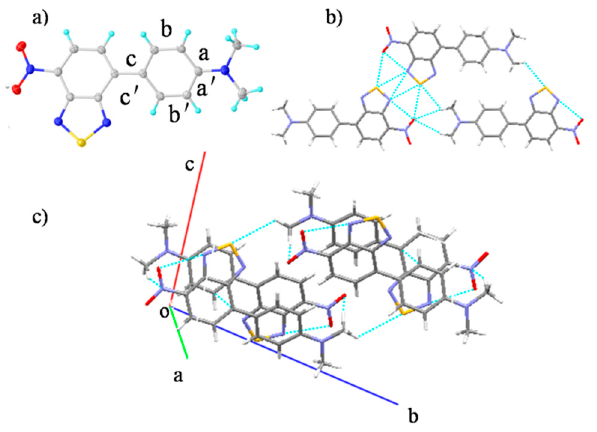
Figure 2. ( a ) Ortep view of BTN with thermal ellipsoids drawn at 50% probability level. ( b ) Front view of molecules with short interactions. ( c ) Crystal packing structure.